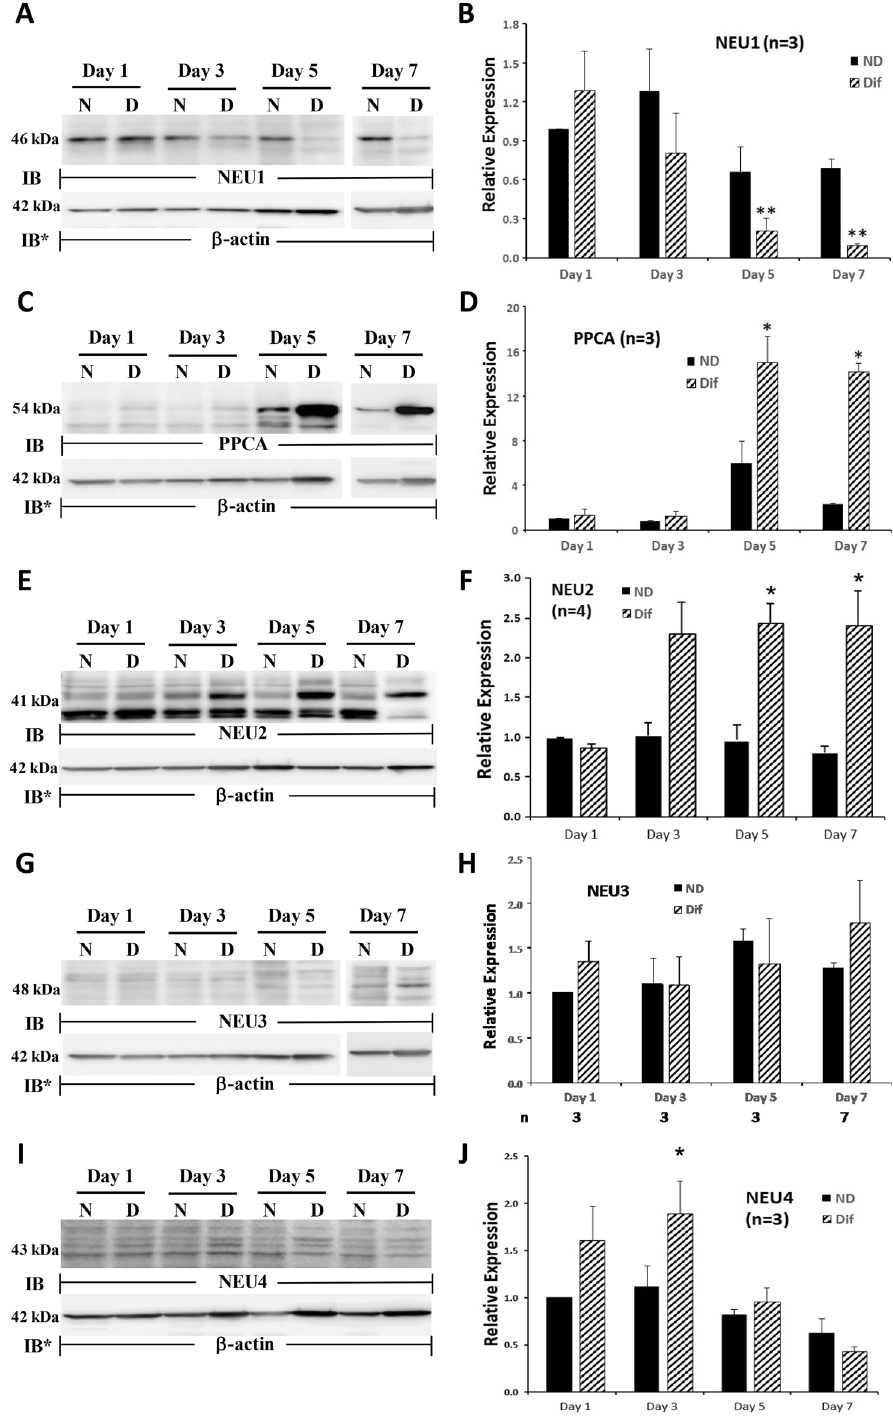
Figure 5. NEU and PPCA Protein Expression During HL60 Cell Differentiation. HL60 cells were cultured for 1, 3, 5 or 7 days in the presence of DMF or medium alone, lysed, and the lysates, at 50 µg total cellular protein/lane, were processed for NEU1 ( A ), PPCA ( C ), NEU2 ( E ), NEU3 ( G ), and NEU4 ( I ) immunoblotting. ( A , C , E , G , and I ) to control for protein loading and transfer, blots were stripped and reprobed for β- actin. IB, immunoblot; IB*, immunoblot after stripping. MW in kDa is indicated on the left. ( B , D , F , H , and J ) densitometric analyses of the blots in A, C, E, G, and I, respectively. Vertical bars represent mean ± SE NEU1, PPCA, NEU2, NEU3, or NEU4 signal normalized to β-actin signal in the same lane on the same stripped and reprobed blot. *, increased normalized PPCA, NEU2, or NEU4 signal in dHL60 cells compared to nondifferentiated cells at p < 0.05. **, decreased normalized NEU1 signal in dHL60 cells compared to nondifferentiated cells at p < 0.05. Each blot is representative of 3–7 independent experiments. Cropped immunoblot images are